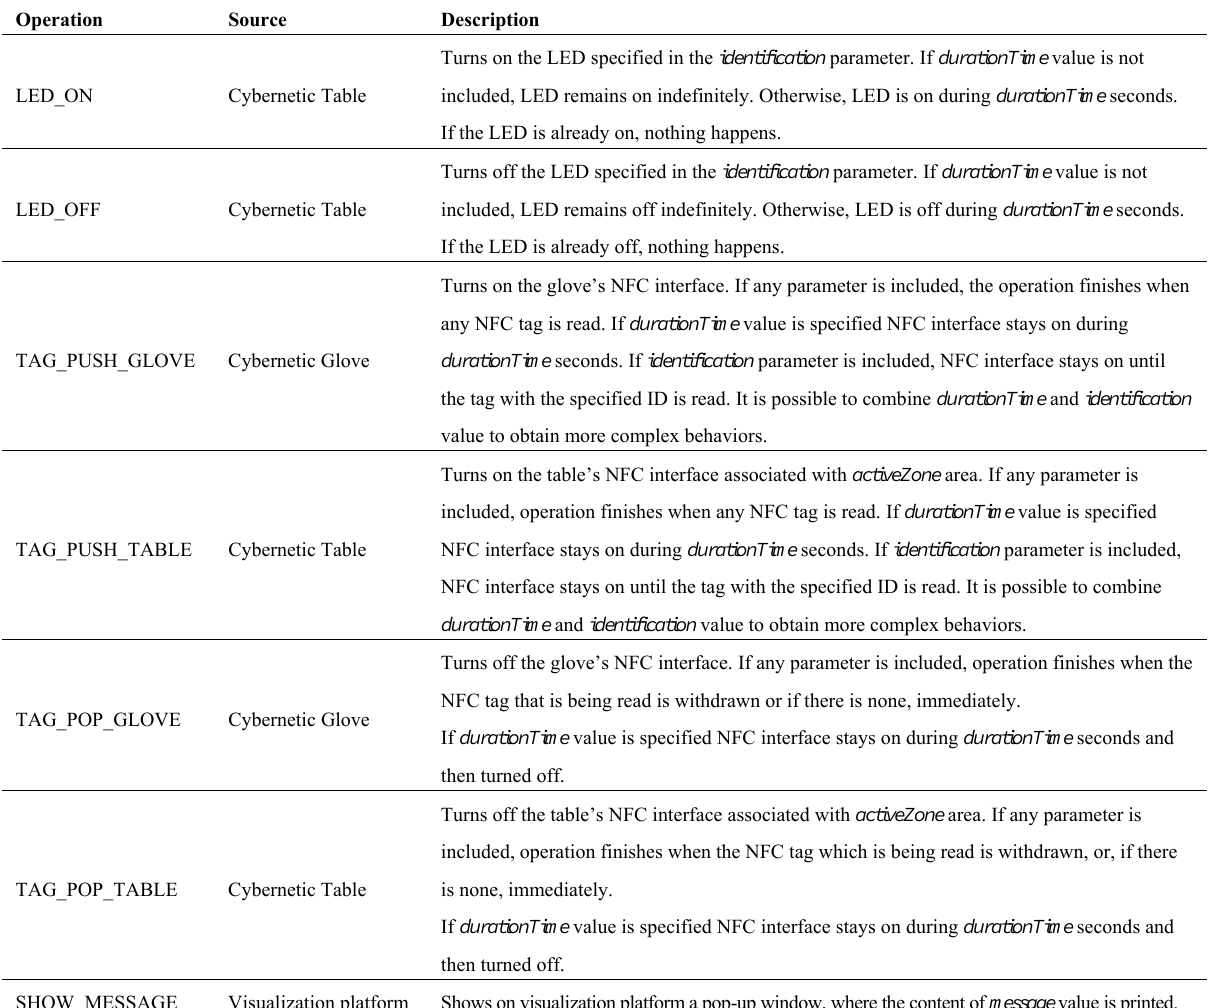
Table 2. Atomic operations currently supported in the